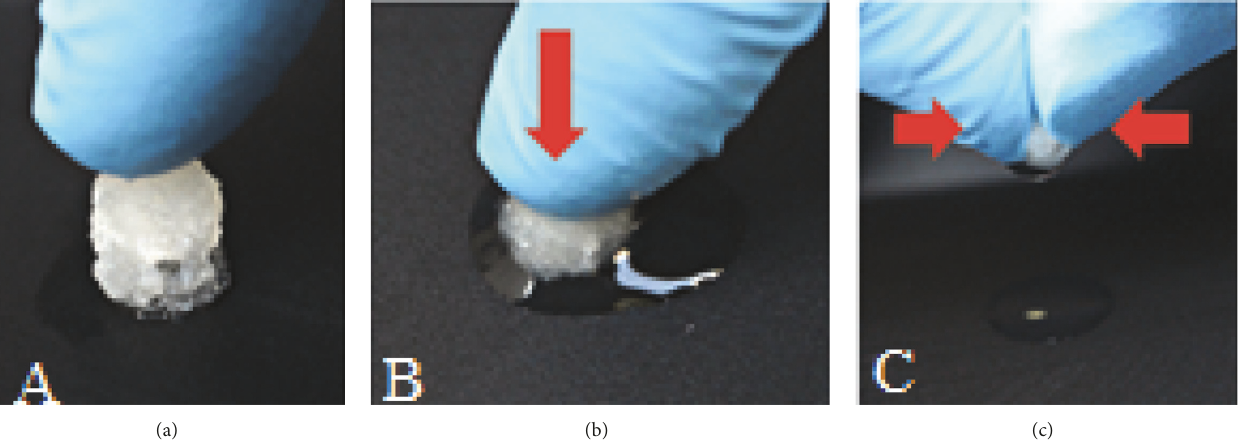
Figure 6: Water uptake ability and retention of SBCS group. (a) Shortly after being removed from the liquid bath, (b) when it was pressed, the liquid came out from the scaffold, (c) when squeezed and pressed harder, the residual liquid still coming out from the scaffold.